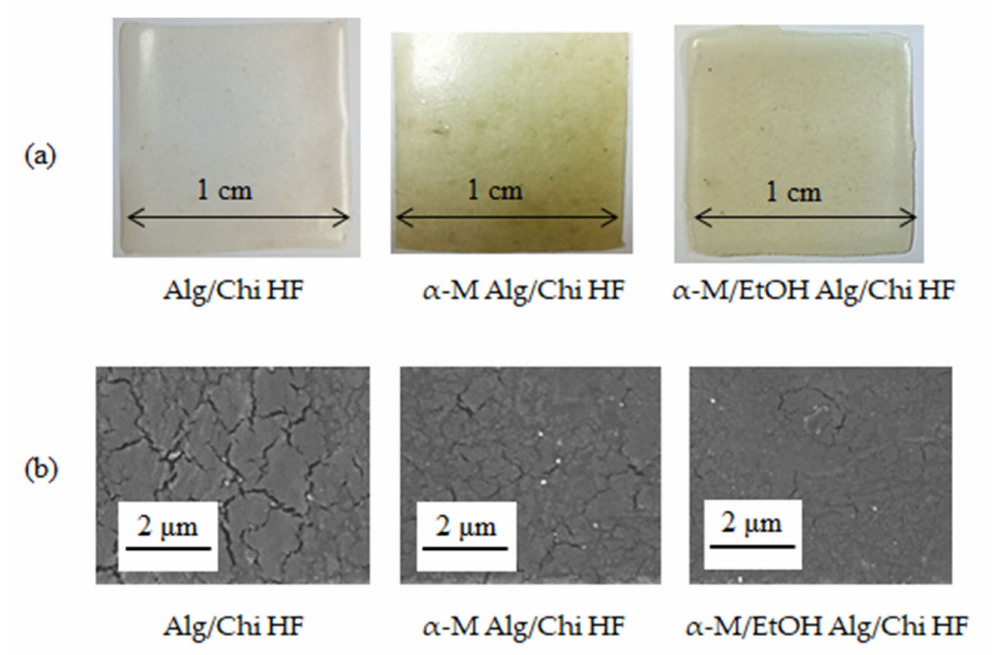
Figure 2. Physical appearances of Alg/Chi HF, α -M Alg/Chi HF, and α -M/EtOH Alg/Chi HF. Macroscopic ( a ) and microscopic ( b )